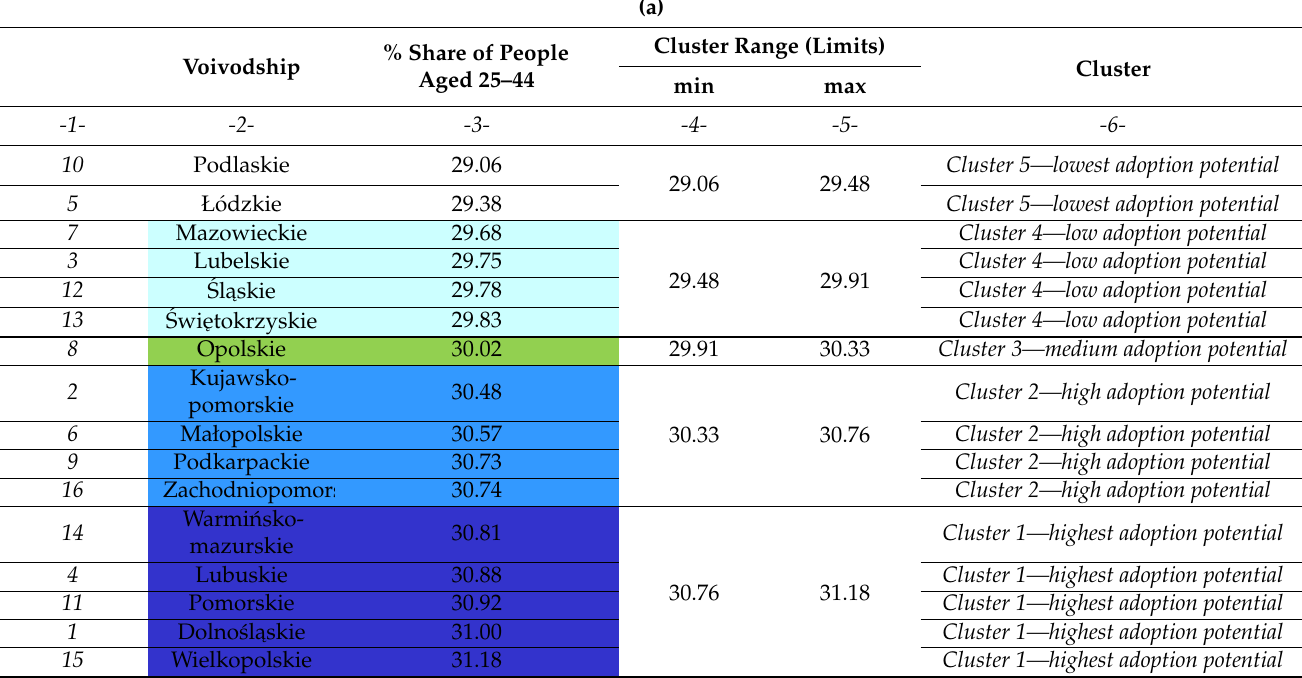
Table 4. ( a ) Resulting Table for 16 voivodships for variable “Age”. ( b ) Calculations for the “cluster interval” for variable